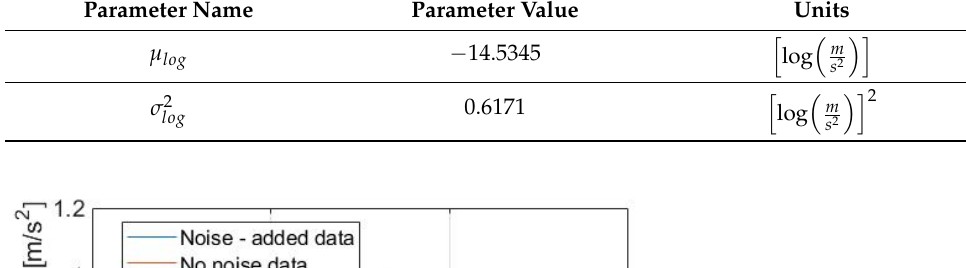
Figure 16. Example of noise-free signal and noise-added signal. Table 2. Lognormal distribution parameters.